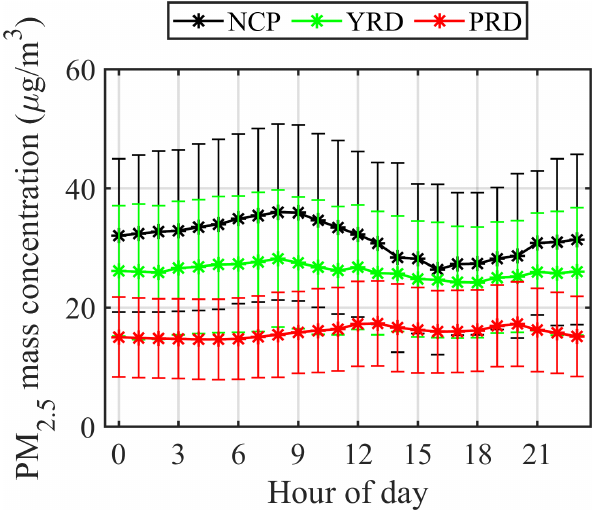
Figure 3. The diurnal variation in PM 2 . 5 mass concentration (µgm − 3 ) during the period of June–August from 2015 to 2020 in the North China Plain (NCP; black), Yangtze River Delta (YRD; green), and Pearl River Delta (PRD, red). The dotted lines are for average values, and the vertical bars are for standard deviations of PM 2 . 5 mass concentration at each